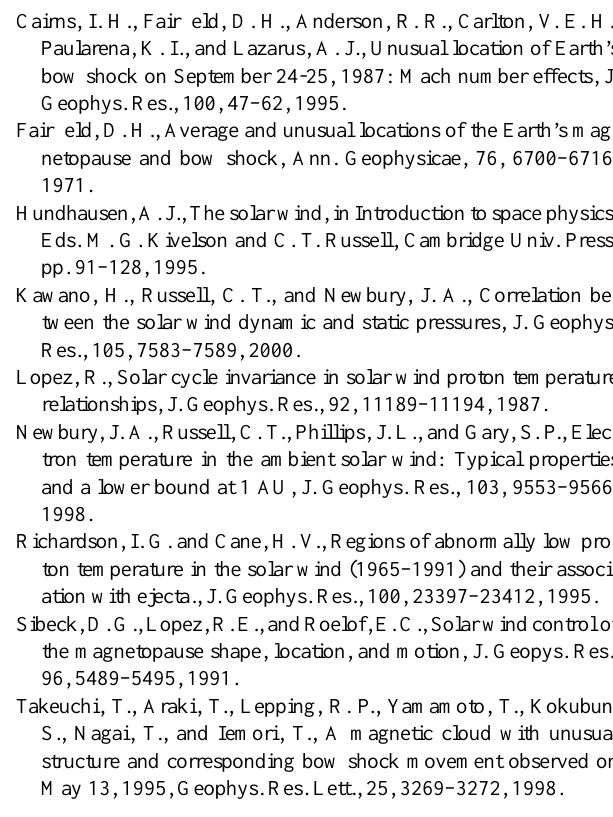
the 11–12 May 1999 is suggested to be in the large positive polarity